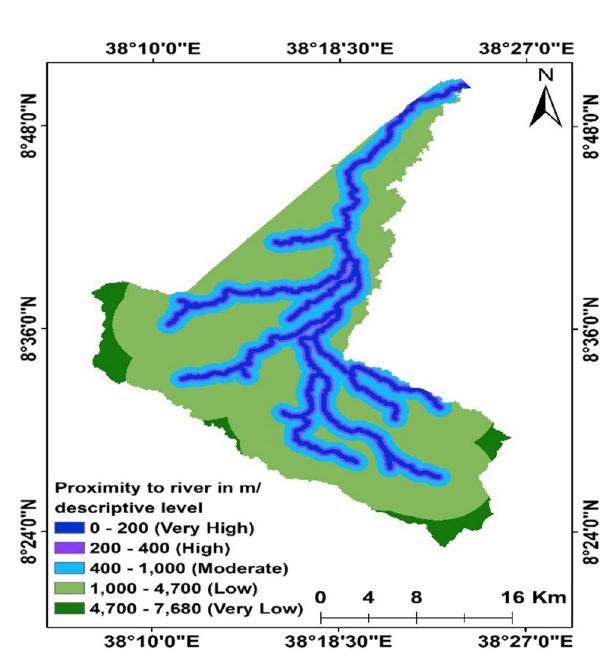
Figure 5 Drainage density map of the study area Figure 6 Proximity to River map of the study